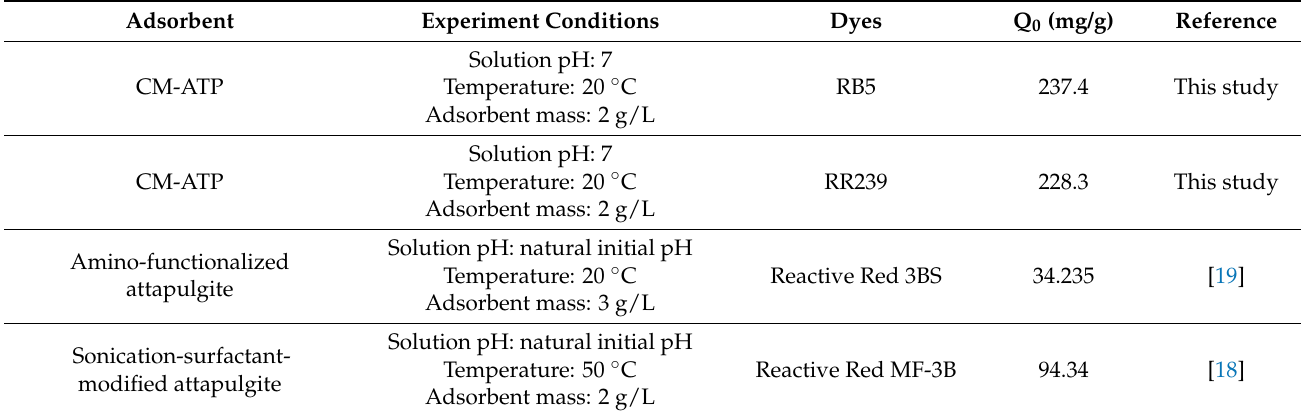
Table 4. Comparison of the adsorption of reactive dyes on CM-ATP and other alternative adsorbents.